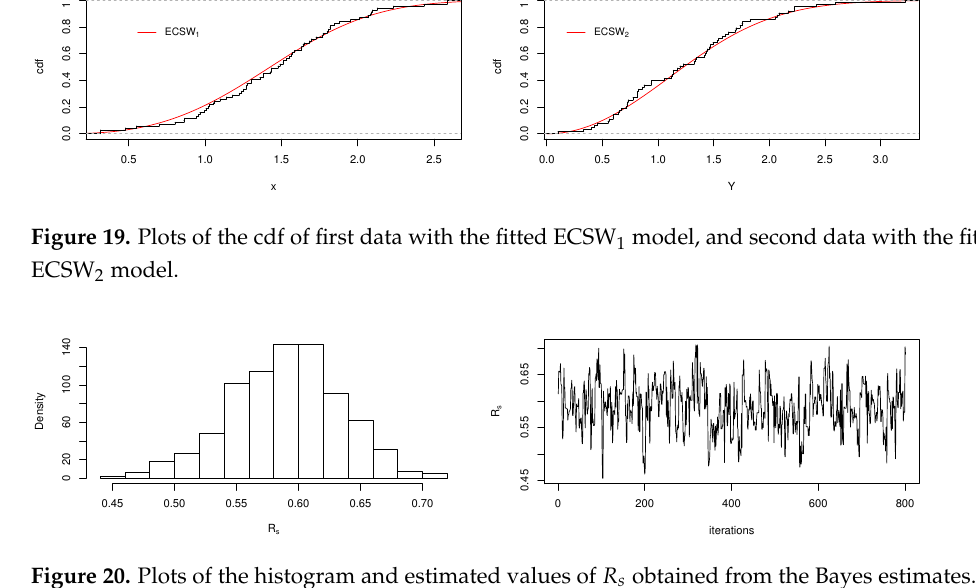
Figure 20. Plots of the histogram and estimated values of R s obtained from the Bayes